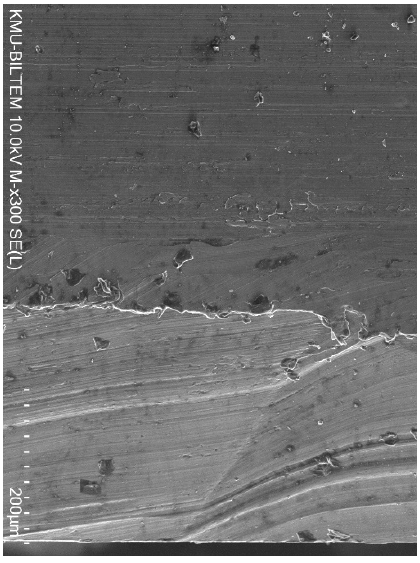
Figure 8. SEM image of hole drilled using TiN/TiAlN-coated tool at the exit, showing the formation of the white layer.